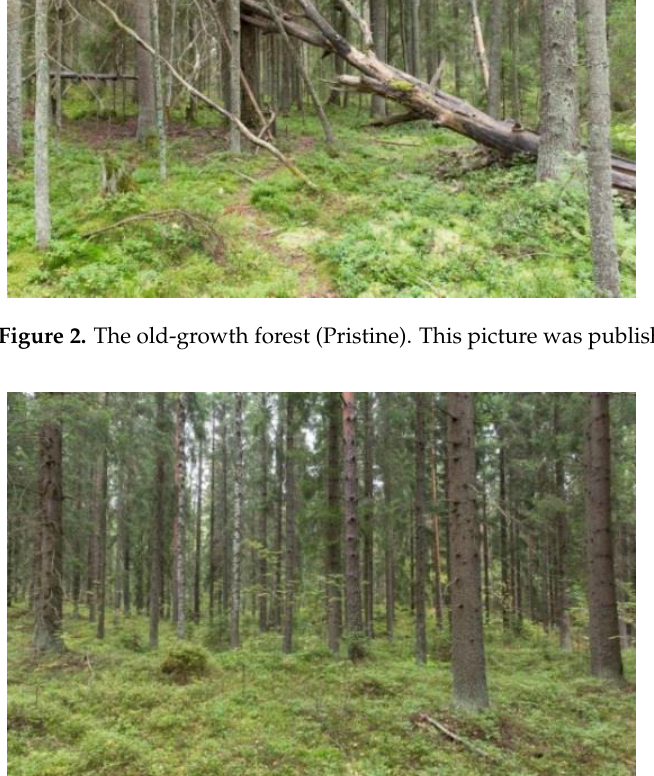
Figure 3. The mature commercial forest (Mature). This picture was published in Reference [66].